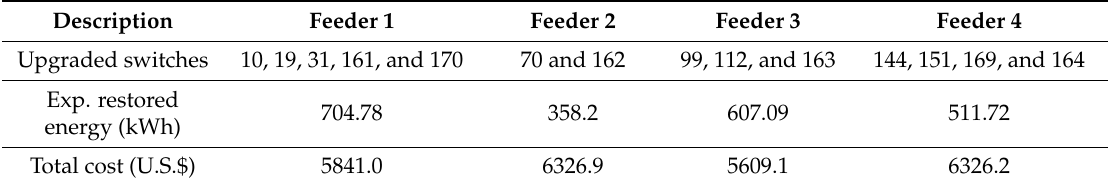
Table 2. Solutions of the proposed